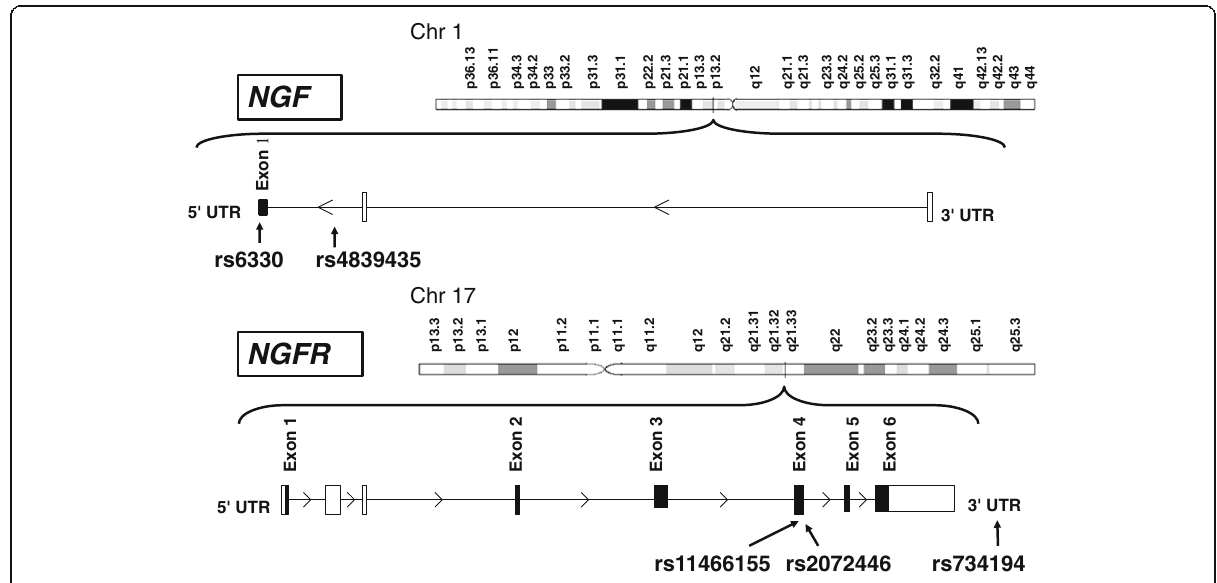
Fig. 1 The localization of the selected 5 SNPs in NGF gene and NGFR